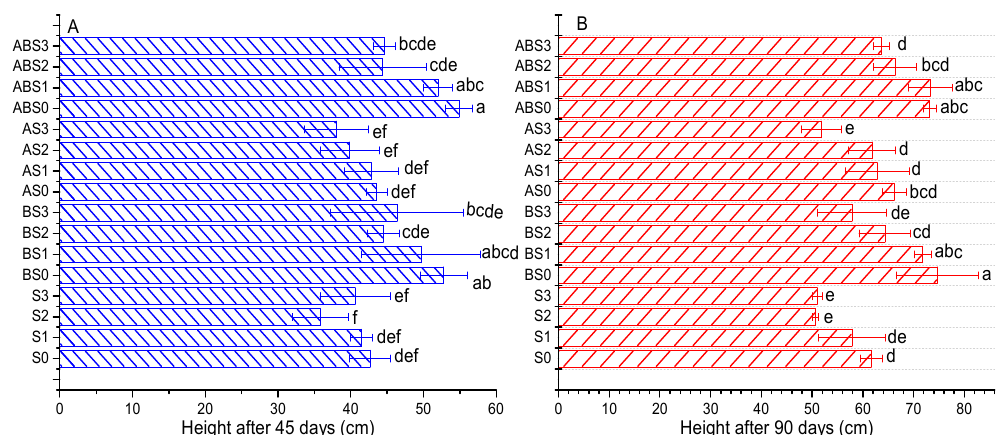
Figure 2. Impact of AMF and biochar on the height of corn plants under different levels of salinity after 45 ( A ) and 90 ( B ) days of growth. Data present the mean ± standard deviation of three replicates and mean values followed by different letters are significantly different at p < 0.05 according to Duncan multiple range test. The significance of acronyms is the same as in Figure 1.